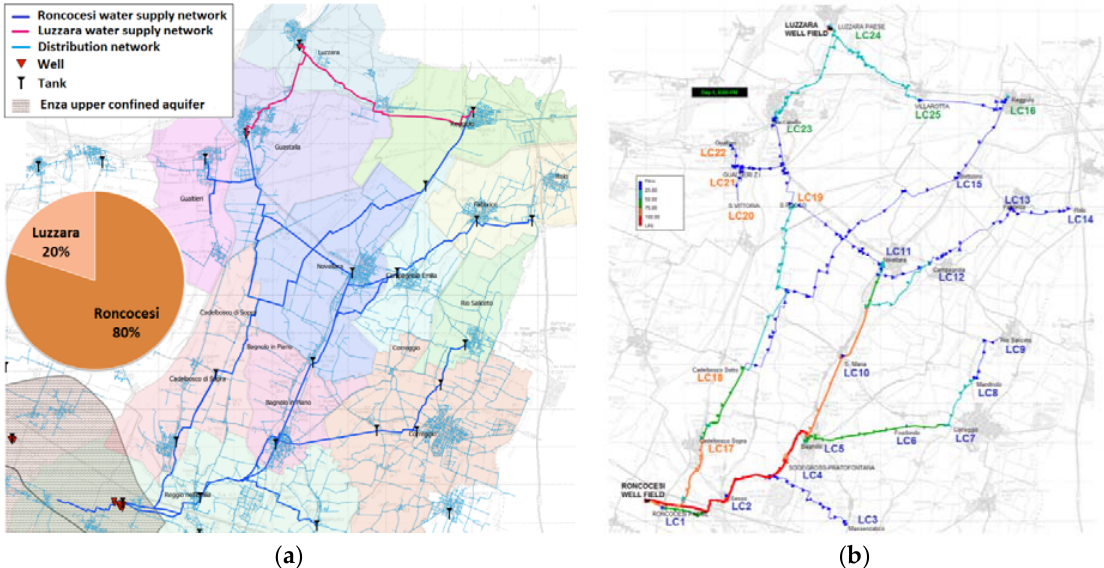
Figure 2. ( a ) Location of Roncocesi and Luzzara water supply systems in Reggio Emilia province, with the percentage of distributed water by each aqueduct; ( b ) Distribution of local areas according to WaterMet 2 model, with flows derived by Epanet simulations. Here, the different colors of local areas (LC) represent the distribution among the subcatchments (LC1 ‐ LC15: SC1, LC17 ‐ LC22: SC2; LC16, LC23 ‐